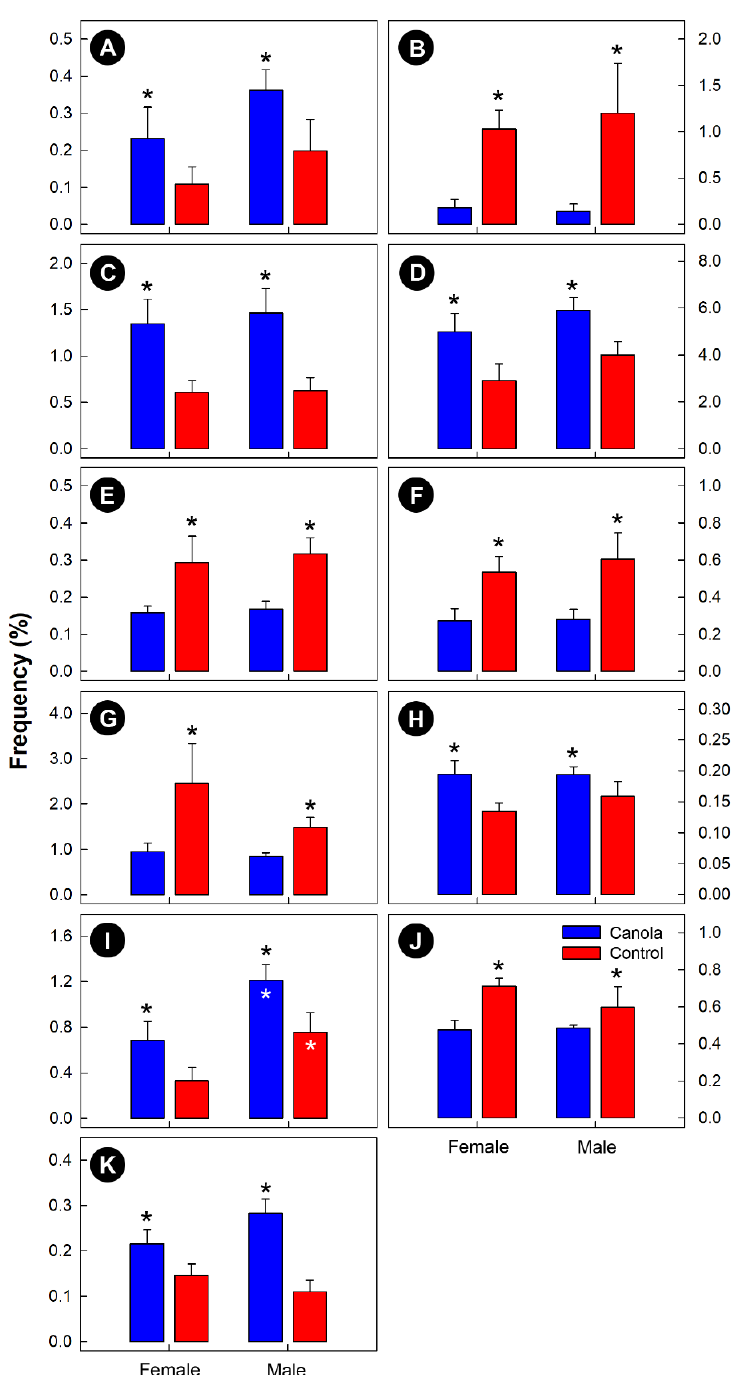
Figure 4. The relative abundance of select archaea and bacterial families ( phylum - family names presented) in the cecal digesta of 35-day-old female and male broilers fed a diet supplemented with canola meal (20%) or a control diet. ( A ) Archaea-Methanobacteriaceae . ( B ) Archaea-Methanocorpusculaceae . ( C ) Actinobacteria-Atopobiaceae . ( D ) Bacteroidetes-Prevotellaceae . ( E ) Bacteroidetes - Bacteroidales D4 uncultured. ( F ) Firmicutes-Christensenellaceae . ( G ) Firmicutes-Clostridiales vadin BB60 group. ( H ) Firmicutes-Clostridiales D4 Family XIII. ( I ) Firmicutes-Peptostreptococcaceae . ( J ) Proteobacteria-Desulfovibrionaceae . ( K ) Proteobacteria-Succinivibrionaceae . The first name is the phylum and second name the family. Vertical lines that are associated with histogram bars are standard error of the means, and histogram bars indicated with a black asterisk indicate that abundances differed ( p ≤ 0.047) between the two diet treatments. Bars marked with white asterisks indicate that abundances differed ( p ≤ 0.050) between male and female